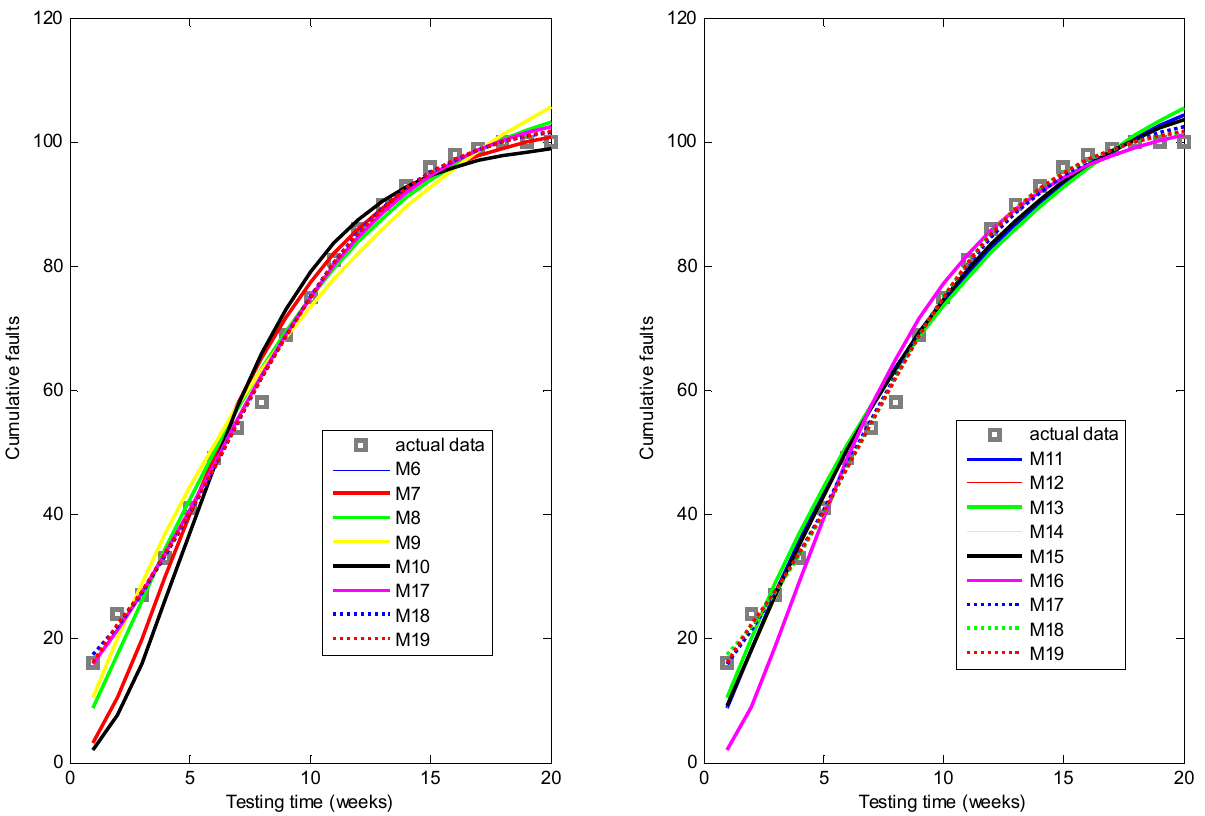
Figure 4. Comparisons of the fitting results for M11-M19 based on DS-2. From Table 5, it is clear that all FCPs of the proposed models provide the top three best results of SRGMs according to these seven criteria values of MSE, R 2 , Adjusted R 2 , PRR , PP , Bias , and Variation